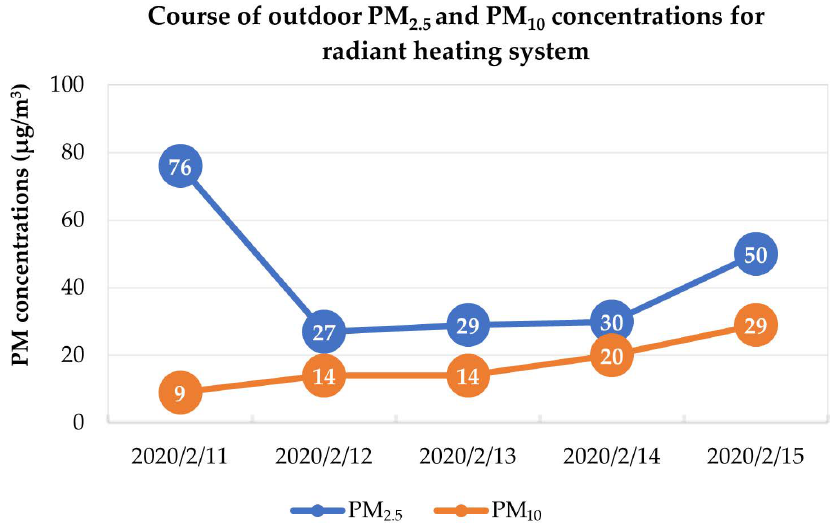
Figure 14. Courses of outdoor PM 2.5 and PM 10 concentrations for RHS